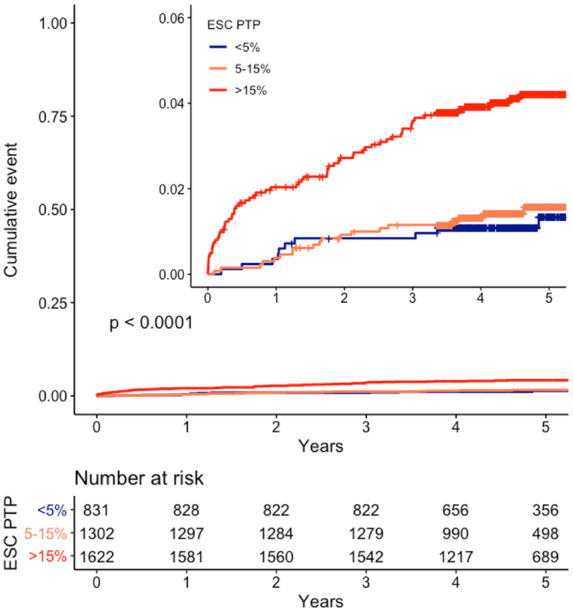
Cumulative incidence of coronary heart disease death or non-fatal myocardial infarction stratified by European Society of Cardiology pre-test probability categories. ESC, European Society of Cardiology; PTP, pre-test probability.